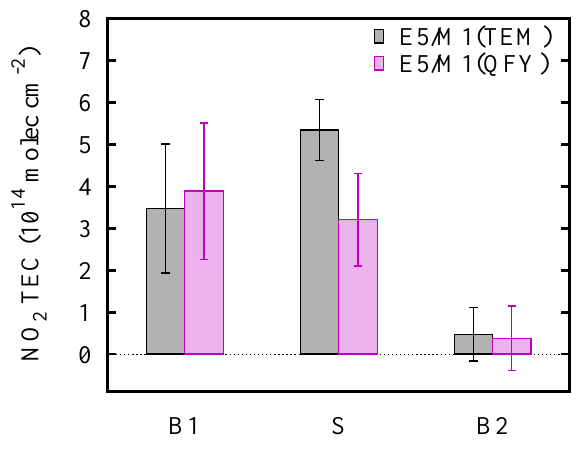
Fig. 7. Mean NO 2 TEC for the year 2003 over the three regions studied from E5/M1(TEM) and E5/M1(QFY). The main difference between the two model runs is the shipping emissions inventory used. The error bar for the model simulations shows the interannual standard deviation.